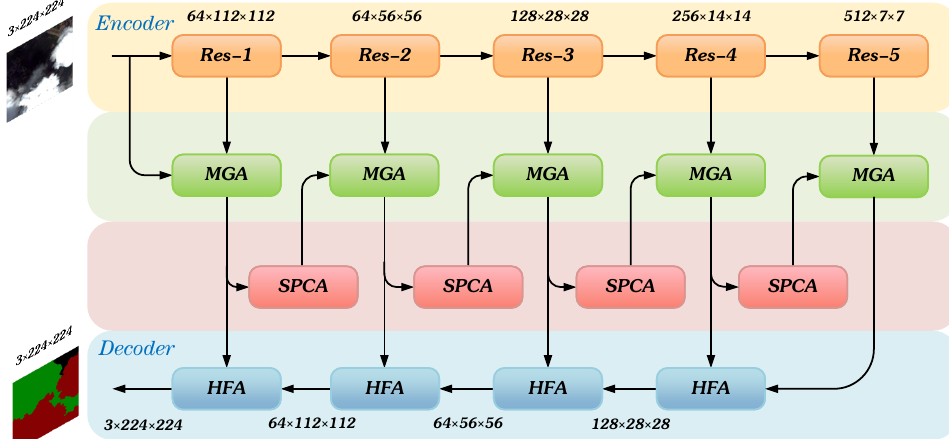
Figure 1. The structure of CRSNet. Res-i are the different levels of ResNet-18. MGA is Multi-scale Global Attention Module. SPCA is Strip Pyramid Channel Attention Module. HFA is Hierarchical Feature Aggregation Module. The size of input and output is 3 × 224 × 224. In the process of encoding and decoding, pictures are extracted into features of various